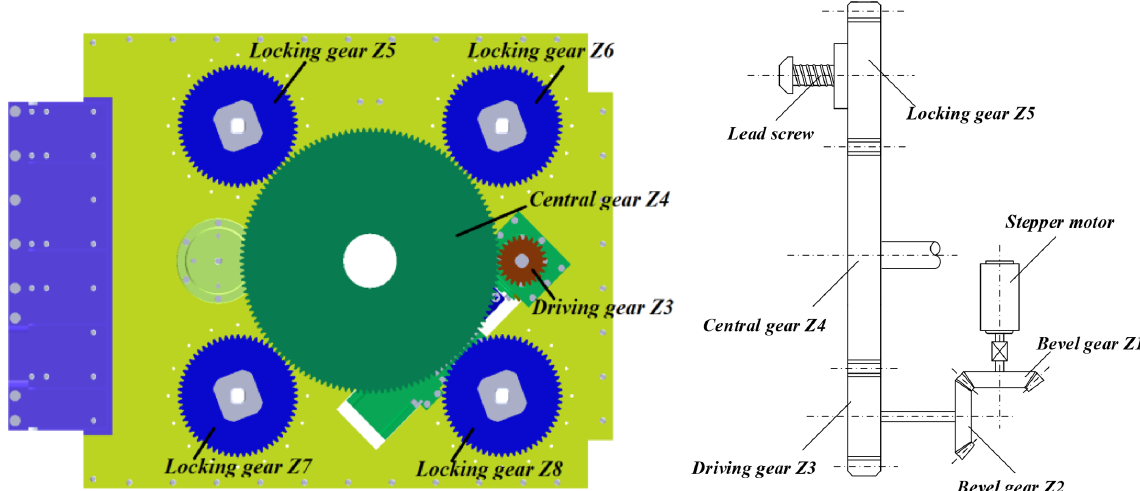
Figure 3. Configuration of transmission train of the L/R mechanism.